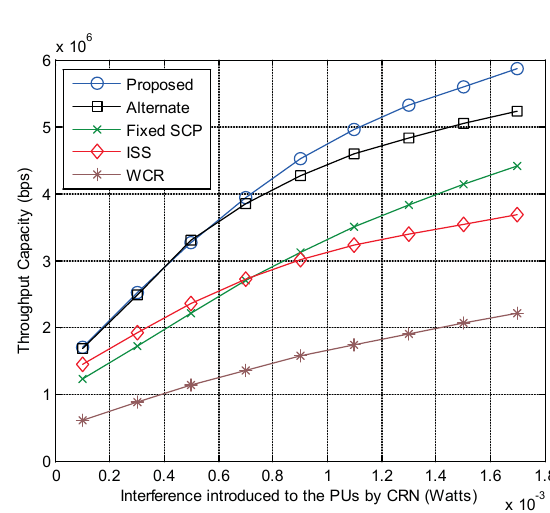
Figure 8. Throughput capacity of the CRN versus interference introduced to the PUs by several schemes with E [ | γ ( sr ) | 2 ] = 8 , E [ | γ ( ss ) | 2 ] = 3 and E [ | γ ( rs ) | 2 ] = 8